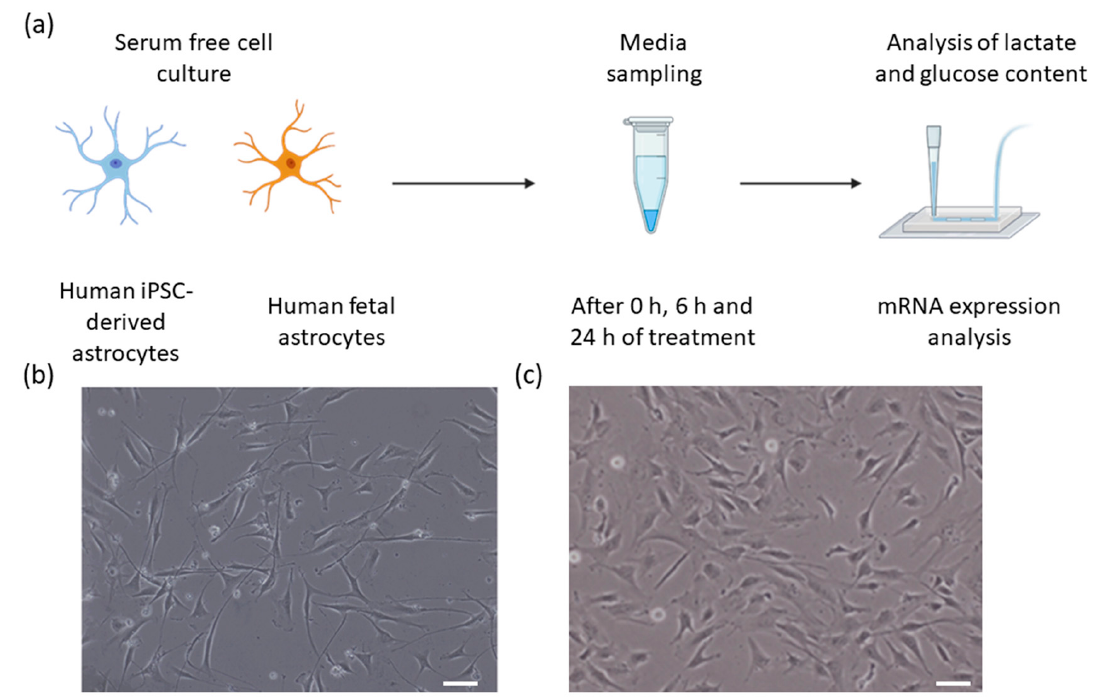
Figure 1. ( a ) An experimental overview of this study illustrating the two cell types, media sampling timepoints, flow sensor analysis of lactate and glucose, and mRNA expression analysis. ( b , c ) Bright-field images of ( b ) Human iPSC-derived astrocytes, and ( c ) human primary astrocytes. Scale bars 50 µm.